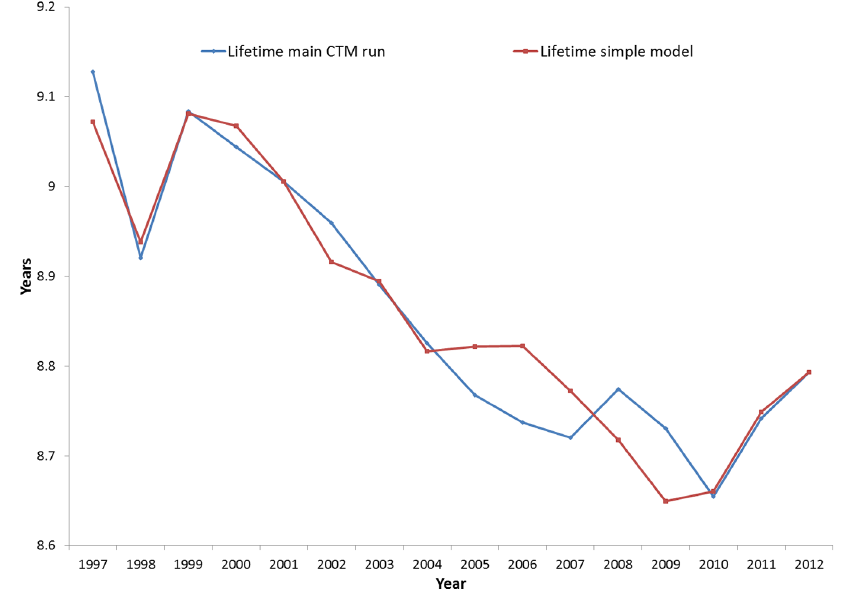
Figure 18. CH 4 lifetime evolution 1997–2012. Comparison of main model simulation (blue line) with CH 4 lifetime from simple model (red line) obtained from multiple linear